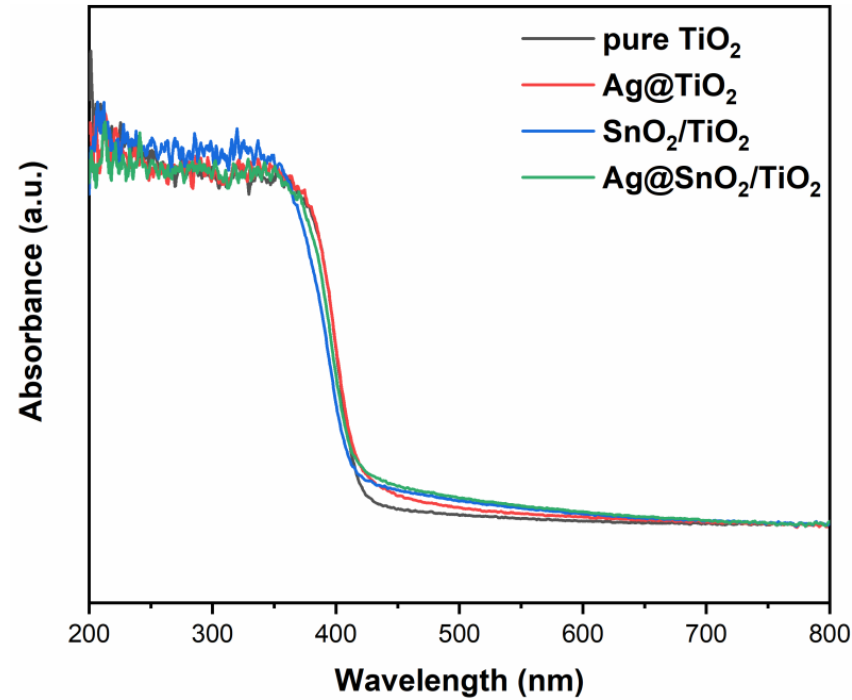
Figure 6. DRS spectra of pure TiO 2 , Ag@TiO 2 , SnO 2 /TiO 2 and Ag@SnO 2 /TiO 2 .